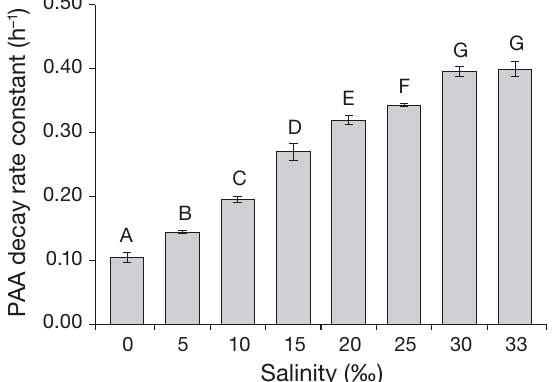
Fig. 3. Calculated first-order PAA degradation rate constants (mean ± SD; n = 3) according to salinity, based on batch exper- iments performed at 20°C with nominal PAA concentration at 1 mg l −1 . All data are based on true triplicate experiments. Different letters denote significant difference (p <